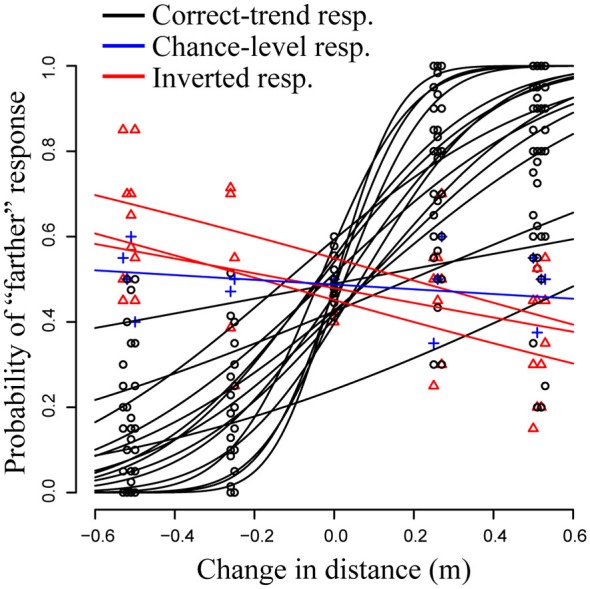
Generalized linear mixed model (GLMM) fit and count data (N = 20) in the VR experiment. One participant responded at chance-level, irrespectively of the change in the stimulus (in blue in the plot). Three participants produced a paradox response, i.e., they reported as farther in space the closer stimuli and vice versa (in red in the plot).